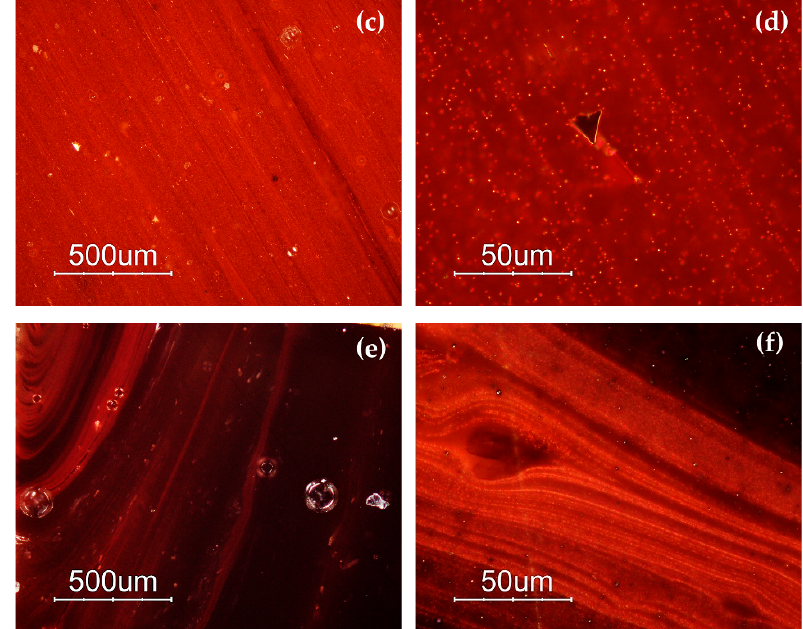
Figure 3 . Optical micrographs in dark field objective: layers of different red hues in sample R4 ( a , b ); sample R10 ( c ) and sparkling crystals less than 50 μ m in sample R17 ( d ); several red bands are present in sample R1 ( e , f ).